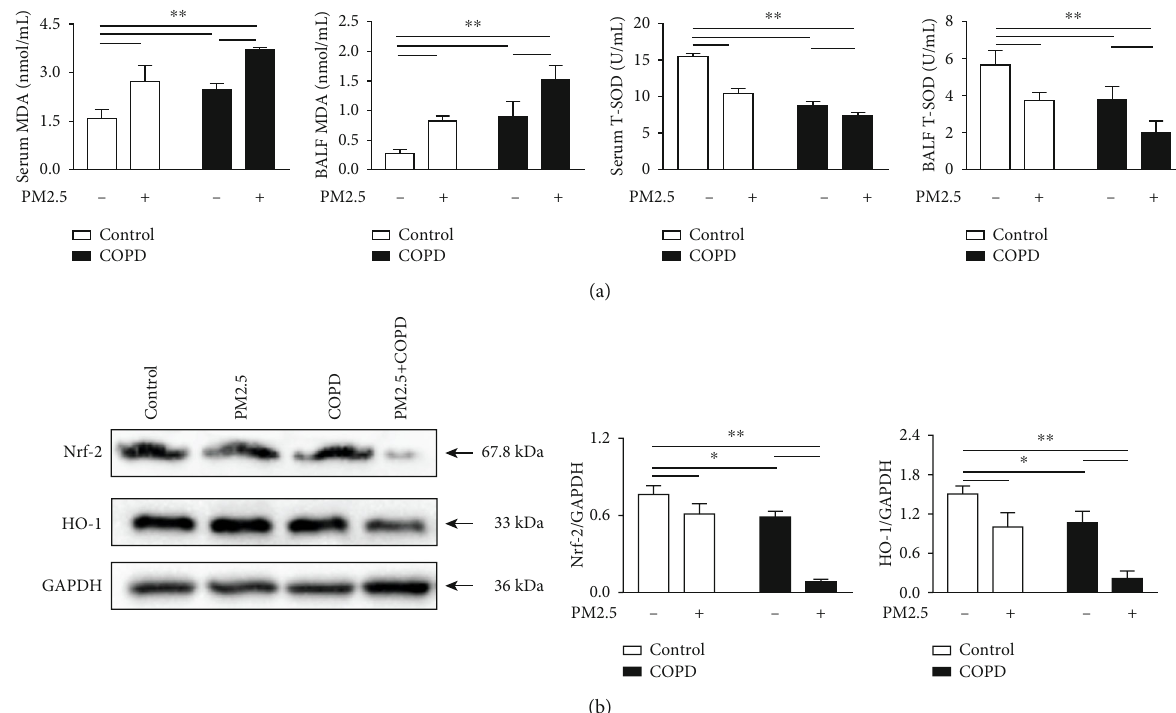
Figure 6: The e ff ect of PM2.5 on oxidative stress in rats with COPD. (a) The levels of MDA and T-SOD in the serum and BALF of rats in each group. (b) Protein expression levels of Nrf-2 and HO-1 in the lung measured by Western blotting. MDA: malondialdehyde; T-SOD: total superoxide dismutase; Nrf-2: nuclear factor erythroid 2-related factor 2; HO-1: heme oxygenase-1. The data are expressed as the means ± SD ( n = 3~7 ). ∗∗ p < 0 : 01 , ∗ p < 0 : 05